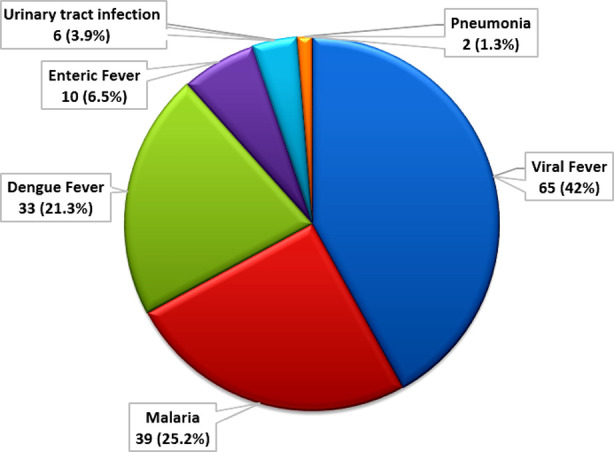
Causes of fever.